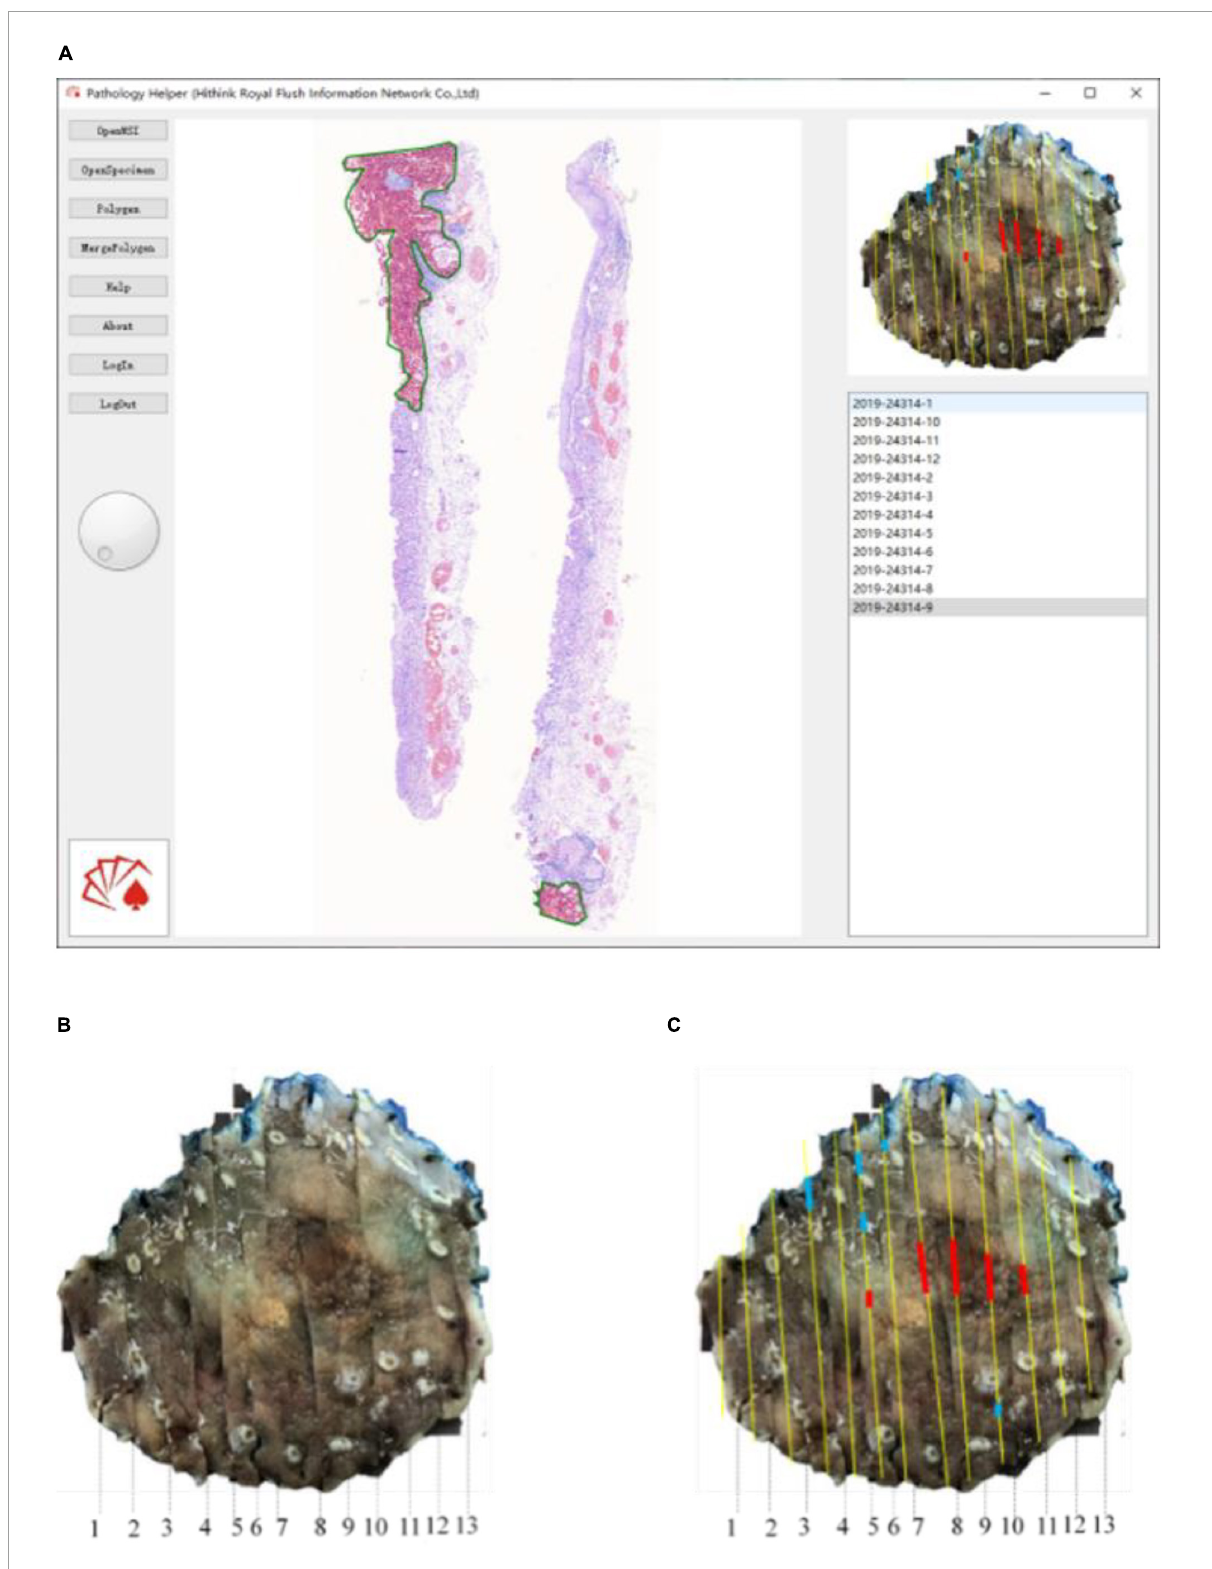
FIGURE9 Whole slide image-level results mapping flow: (A) Mapping with Pathology Helper software; (B) specimen photo; (C) mapping